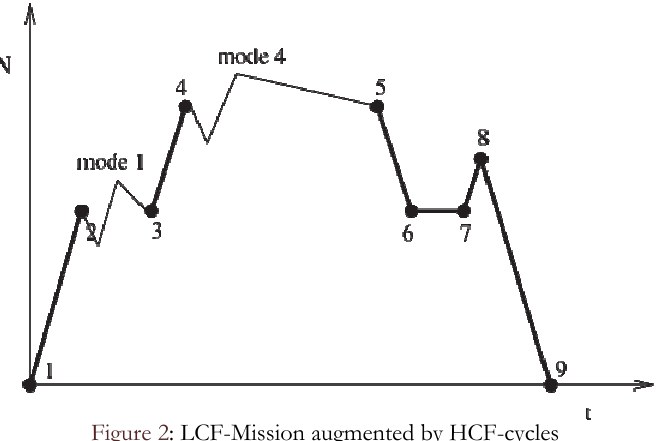
Figure 2: LCF-Mission augmented by HCF-cycles